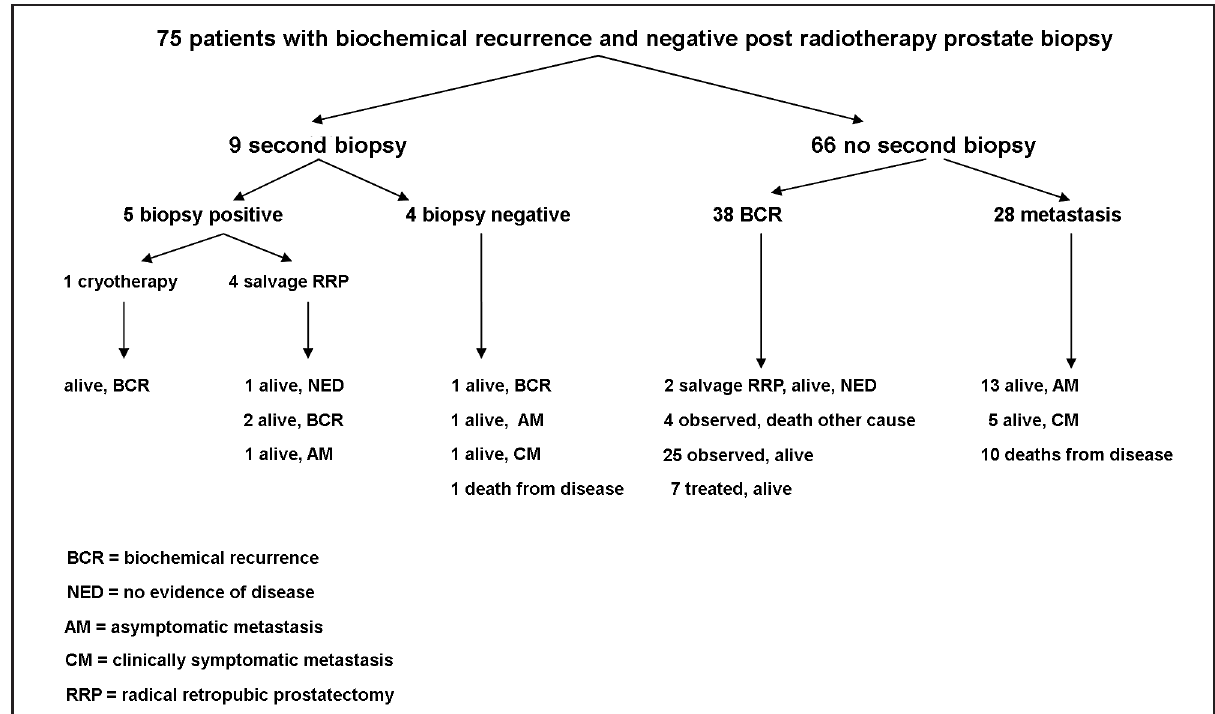
Figure 1 – Clinical